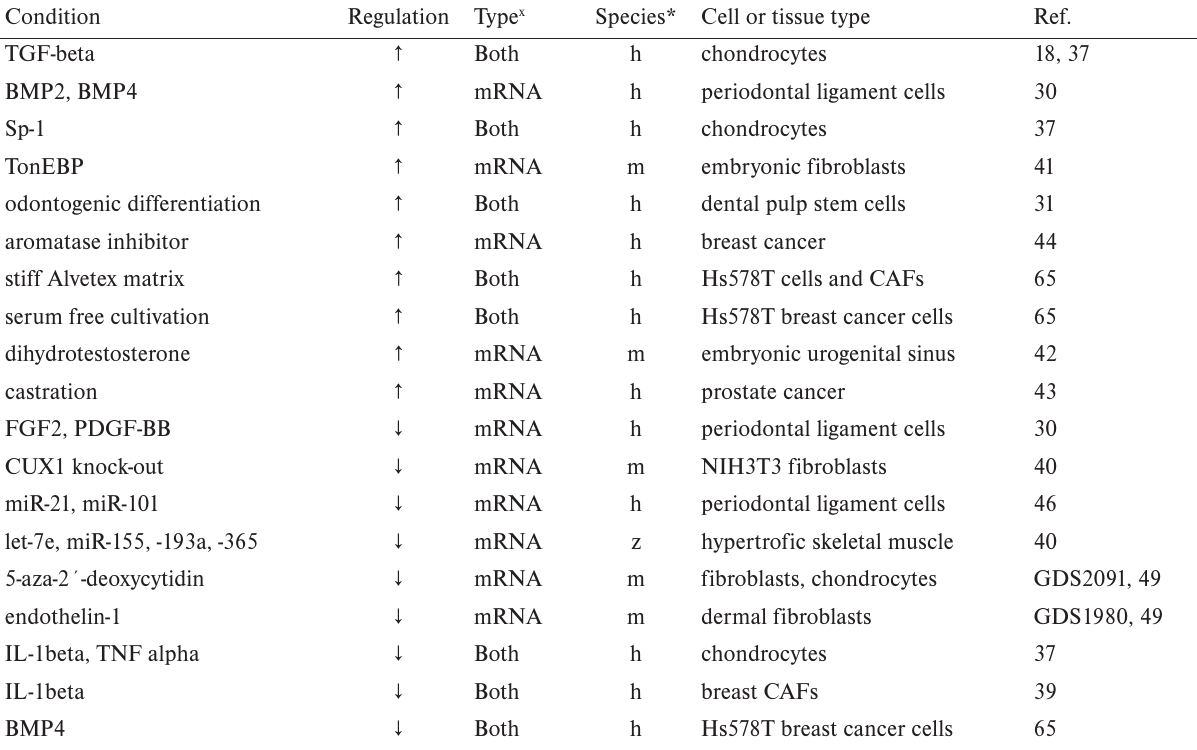
Table 1. Regulation of asporin expression in different conditions and cell